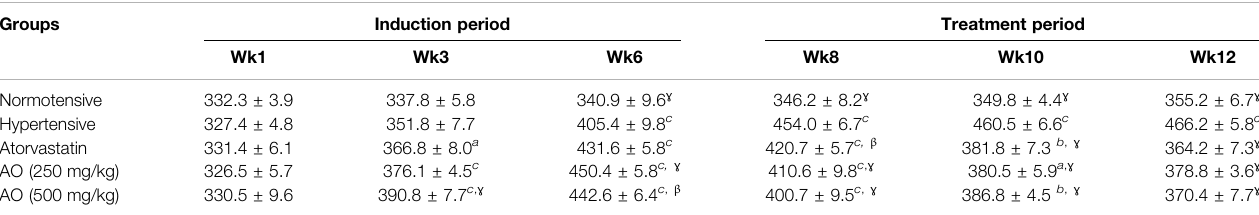
TABLE 5 | Effect of administration of Alpinia of fi cinarum on heart rate (HR) beats per minute in chronic obesogenic diet-fed hypertensive rats.